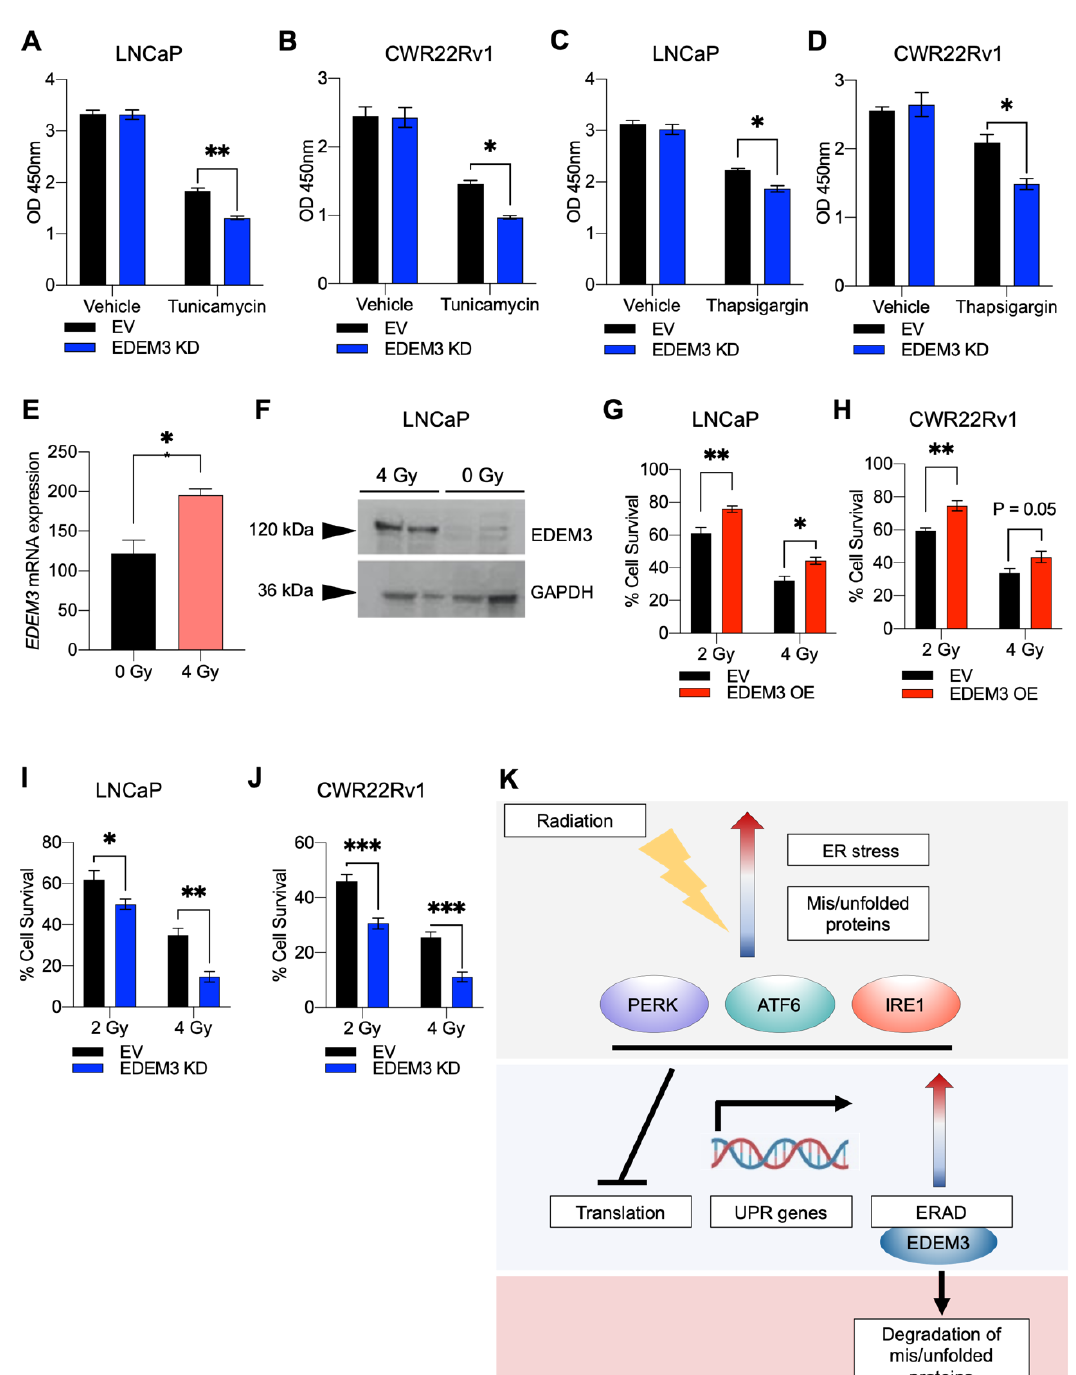
Figure 5. EDEM3 depletion in prostate cancer sensitises cells to ER stress and its upregulation promotes radio-resistance. ( A – D ) Cellular viability of LNCaP and CWR22Rv1 cells, with knockdown of EDEM3, treated with either vehicle (DMSO), 100 nM thapsigargin or 2.5 µg/mL tunicamycin, for 24 h. Viability measured by WST-1 assay and shown as absorbance at O.D 450 nm. n = 3. Data are mean ± s.e.m. p values were calculated using two-tailed unpaired t -tests. * p < 0.05 and ** p < 0.01 ( E ) mRNA levels of EDEM3 in LNCaP cells 48 h after exposure to 4 Gy radiation. Data are presented as mean ± s.e.m. p value calculated using a two-tailed unpaired t -test. * p < 0.05. ( F ) Western blot analysis of EDEM3 expression in LNCaP cells 48 h after exposure to 4 Gy radiation. GAPDH was used as a loading control. ( G , H ) Cell survival determined by clonogenic assay. LNCaP and CWR22Rv1 cells transfected with either an empty vector or EDEM3 overexpression vector were irradiated with either 2 or 4 Gy and left to form colonies for 14 days. At 14 days, any colony with more than 50 cells